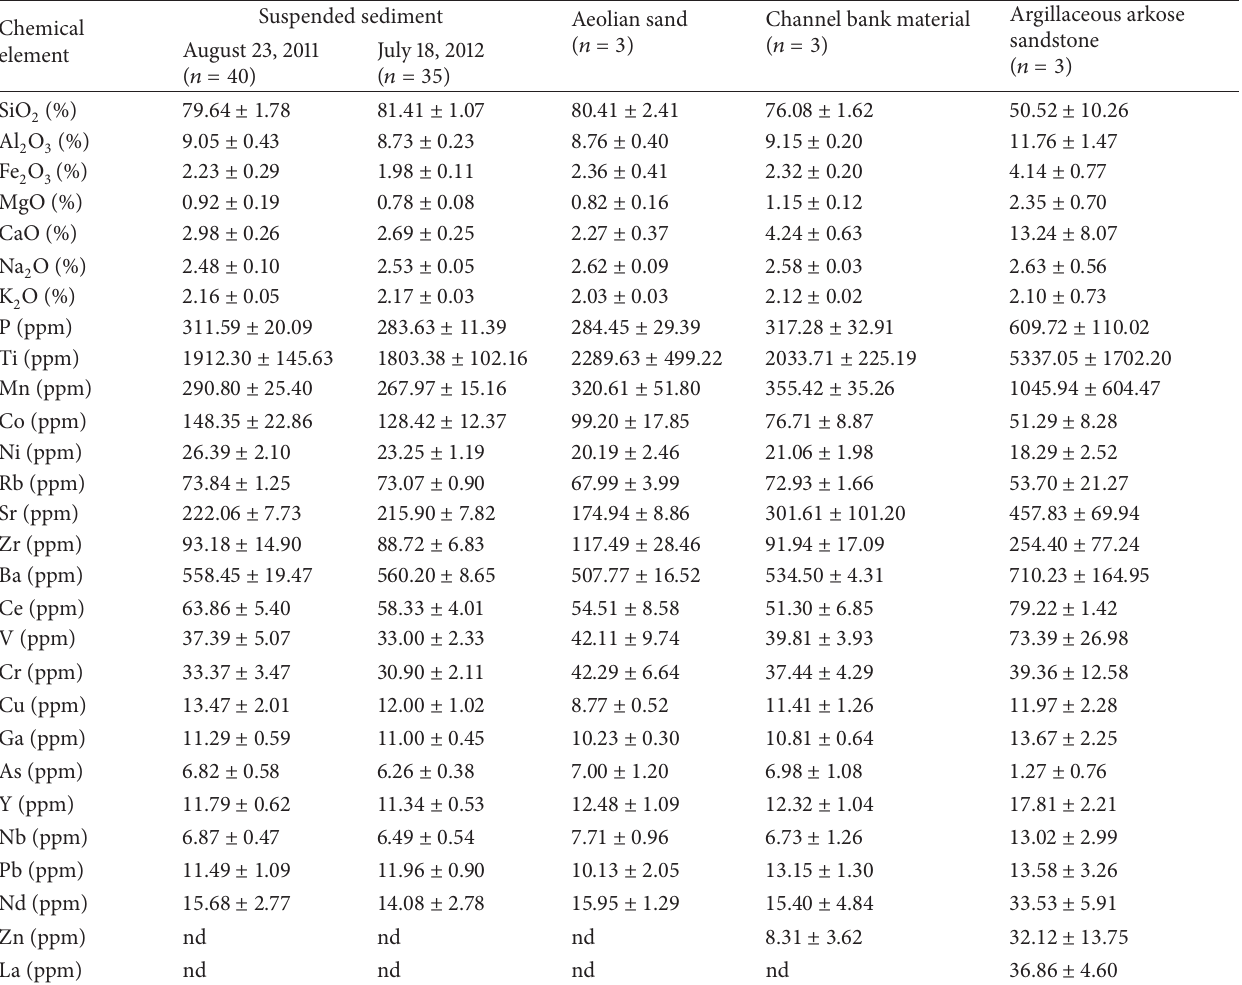
Table 2: Mean ( ± SD) concentration of elements in the suspended sediment and the three source areas. Chemical